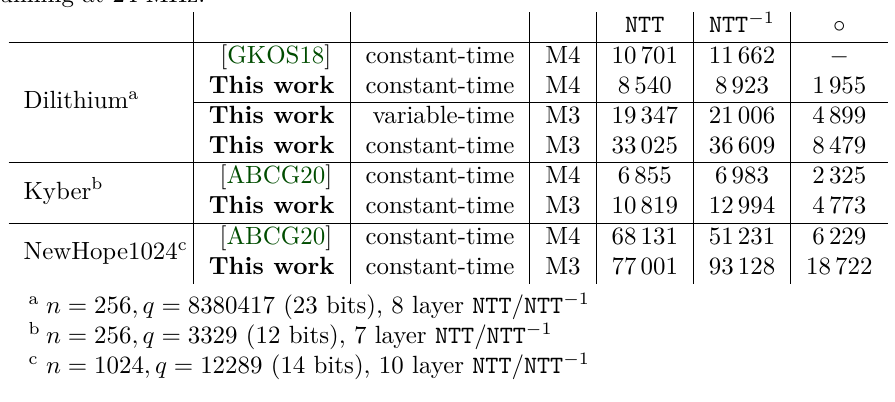
Table 2: Performance results for NTT , NTT − 1 , and ◦ of Dilithium, Kyber, and NewHope for the Cortex-M3 and the Cortex-M4 reported in clock cycles. The Cortex-M3 (SAM3X8E) is running at 16MHz, and the Cortex-M4 (STM32F407) is running at 24